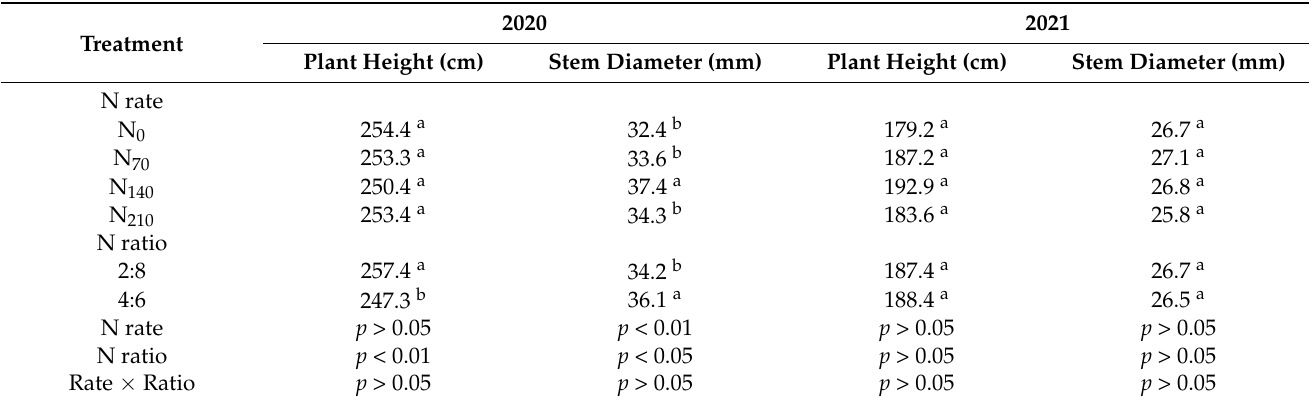
Table 2. Effects of different fertilization rates and basal topdressing ratios on plant height and stem diameter in 2020 and 2021.